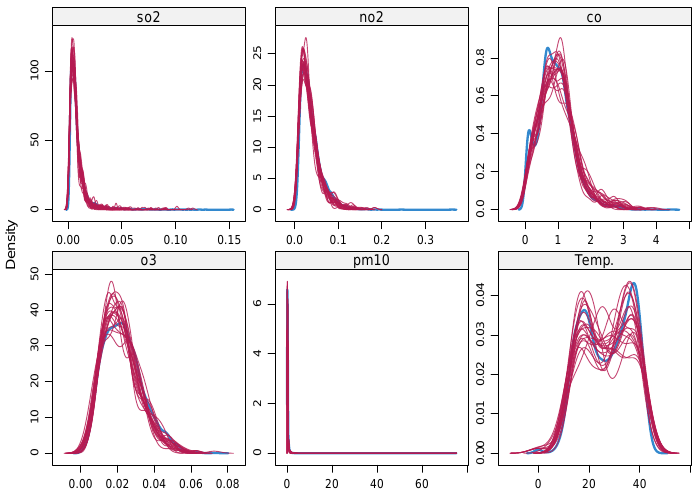
Figure A8. Density plots with multiple imputations for SO 2 , NO 2 , PM 10 , CO , and O 3 data. The blue line represents the observed data and the red lines are the density plots of the 20 imputed data sets. As we can see, in all density plots, the red lines almost match the blue line (the observed data), which is an indication of matching between the observed and imputed values.